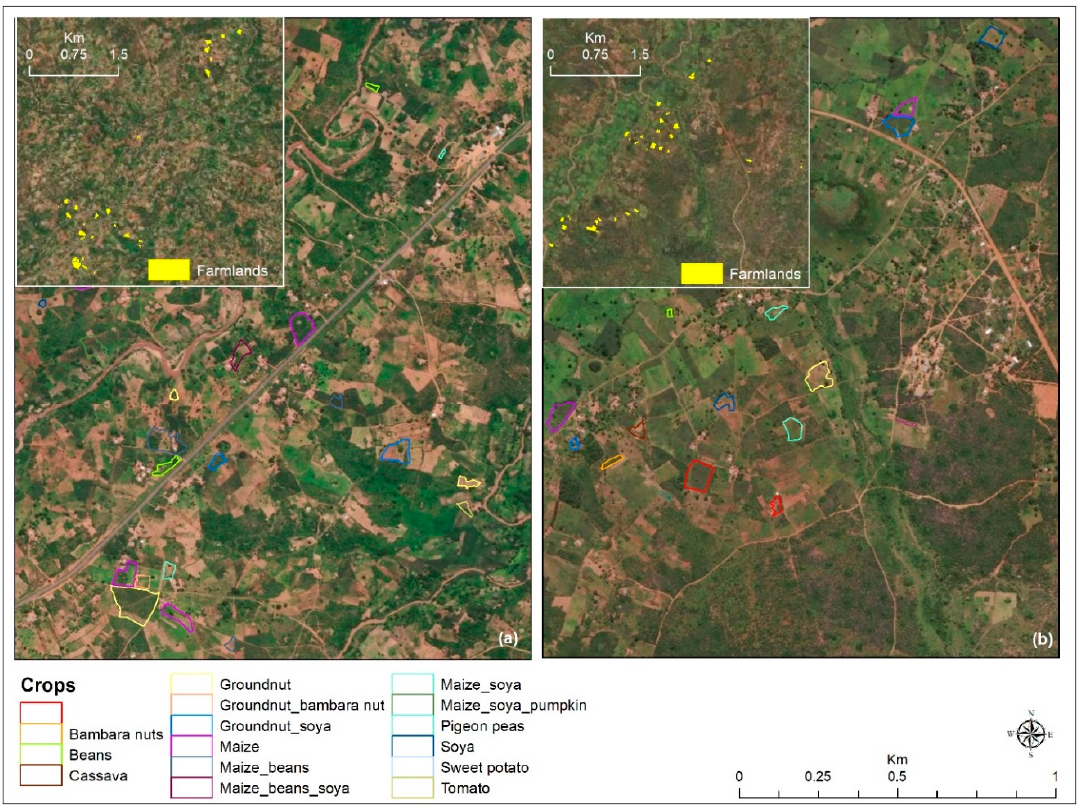
Figure 4. Extents of farms surveyed by farmers in ( a ) Edundu and ( b ) Thimalala. The inset map shows all the mapped farms. The base map is obtained from ESRI ArcMap v10.71. Inset maps represent entire areas covered during fieldwork.